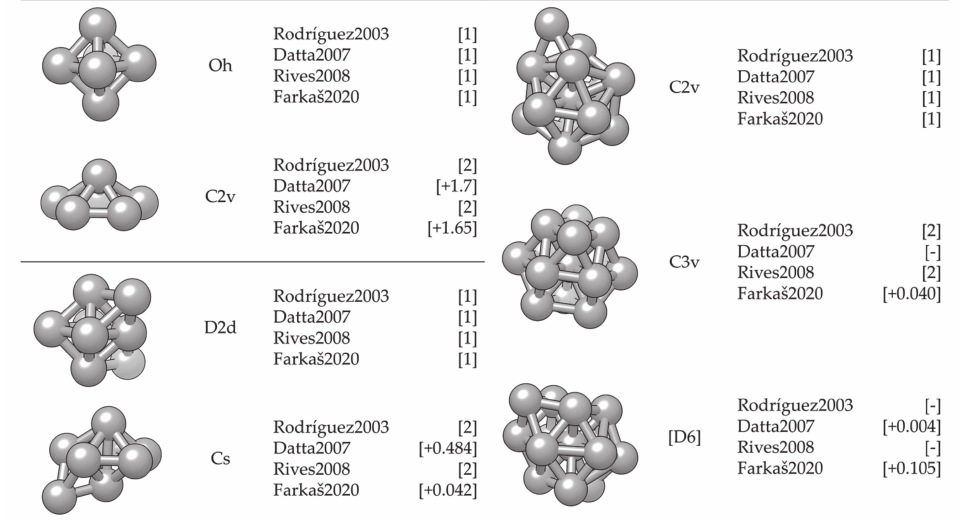
Figure 3. Agreement between most stable cluster structures of 6-, 8-, and 14-atom Co as predicted by DFT [239,254] and MD [252,253] simulations. For DFT studies, energy difference between the structural isomers is given in the square brackets in eV.